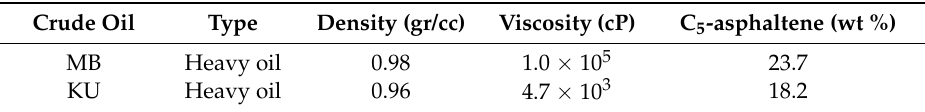
Table 2. Crude oil properties at 298